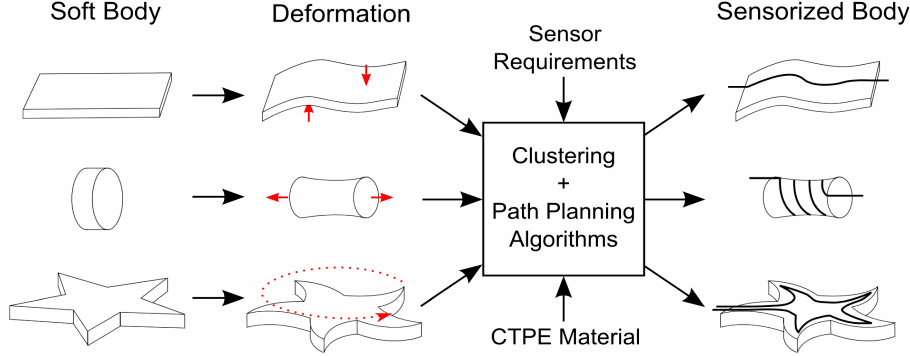
Figure 1. A conceptual schematics of the SVAS3 approach. Three examples of soft bodies are deformed (shown with red arrows) and sensorized with CTPE-based sensors (shown with black